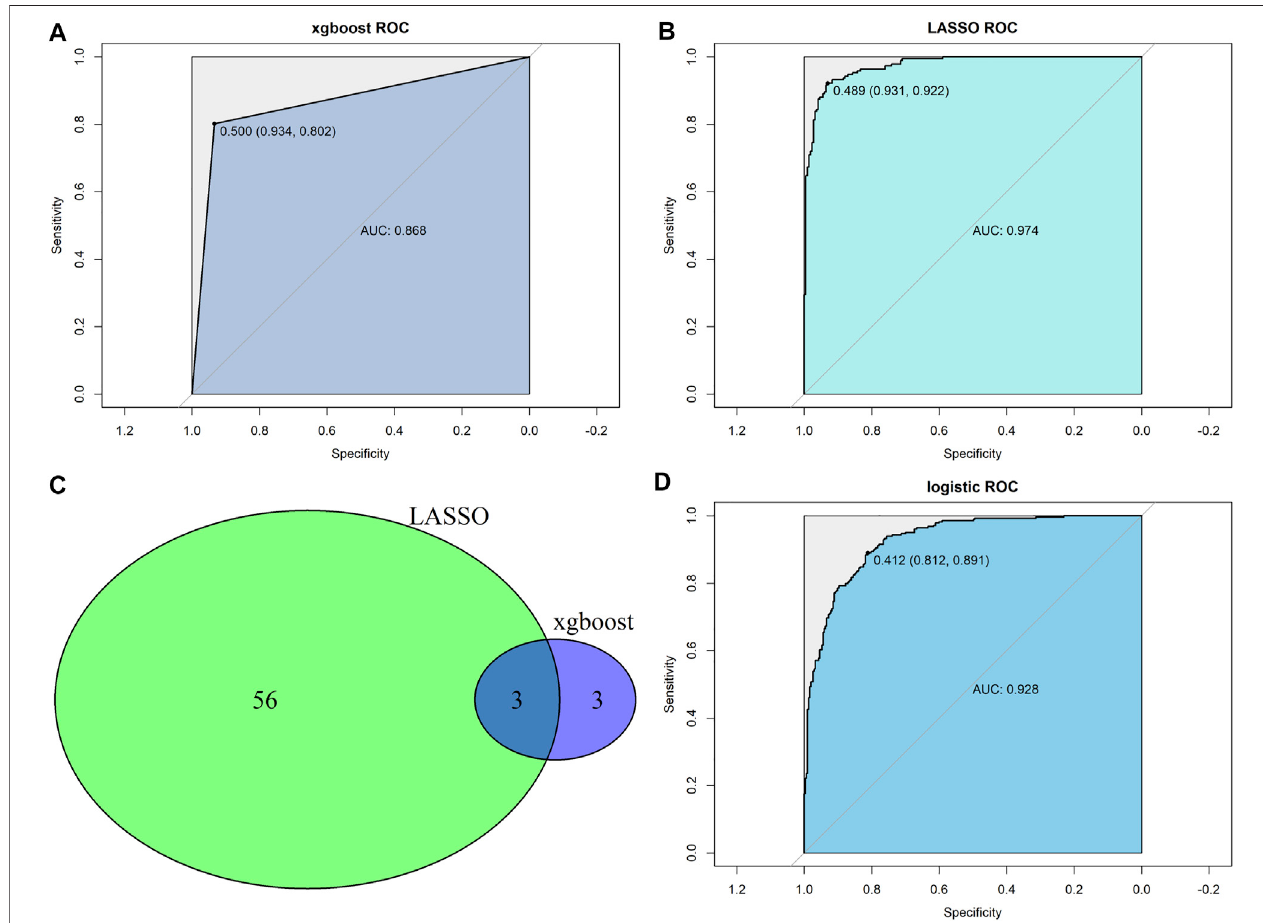
FIGURE 6 | Construction of predictor for the stemness subtypes. (A) XGBoost algorithms identi fi ed a model predicting the stemness subtypes; (B) LASSO algorithmsidenti fi edamodelpredictingthestemnesssubtypes. (C) Venndiagramidenti fi edoverlappedgenesbetweenxgboostandLASSOalgorithms. (D) Multivariate logistic regression model revealed the diagnostic value in predicting the stemness subtypes.